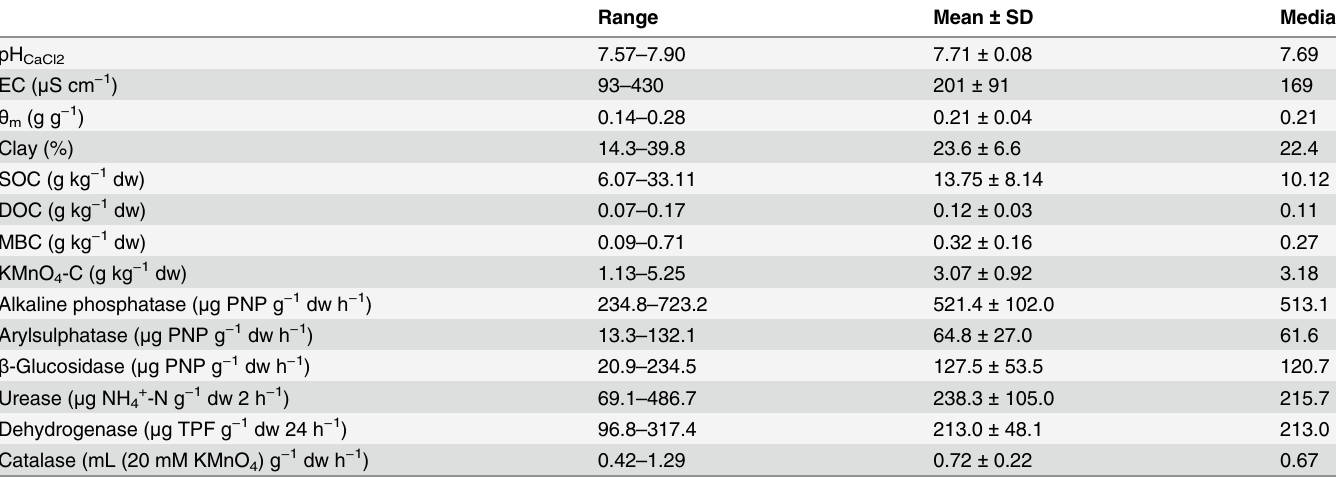
Table 3. Major characteristics of agricultural soils along the WYR ( n =